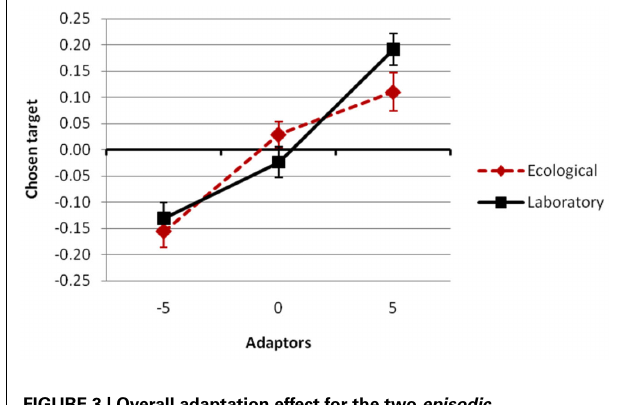
FIGURE 3 | Overall adaptation effect for the two episodic compatibility conditions ecological (leisure condition in the test phase; red dotted line) and laboratory (laboratory condition in the test phase; black solid line) . Three kinds of adaptors were used varied across groups: − 5 (participants adapted to strongly compressed versions of the faces), 0 (participants adapted to the original faces), and 5 (participants adapted to strongly extended versions).The average distortion value of the selected faces during test served as the dependent variable (Chosen target; y -axis). See Section “Results” for